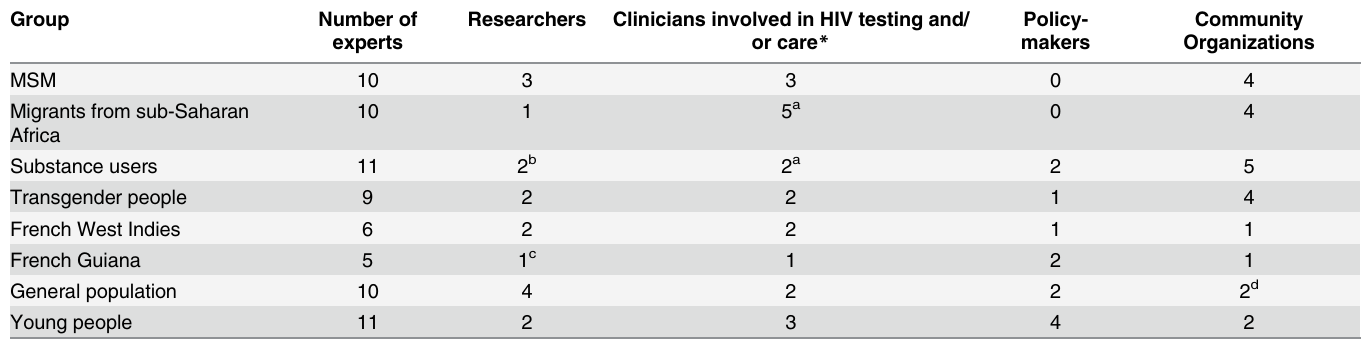
Table 1. Characteristics of the experts in each population group.